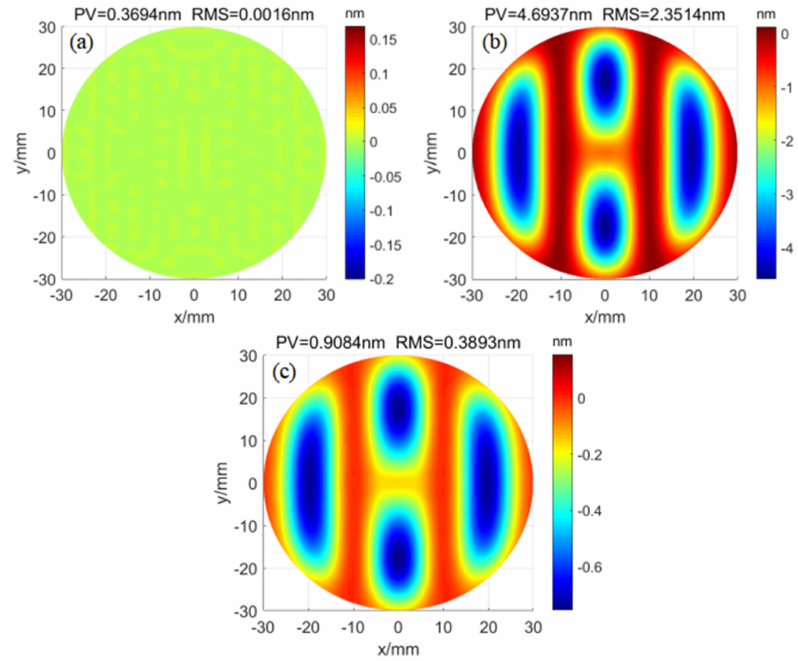
Figure 11. Simulation residual error of the case of no angular error ( a ), the case of 1 ◦ angle error ( b ), and the case of 10 (cid:48) angle error ( c